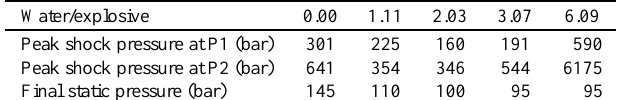
Table 2 The peak shock pressure and final static pressure in the cube chamber at different water/explosive ratios for a loading density of 9.80 kg/m 3